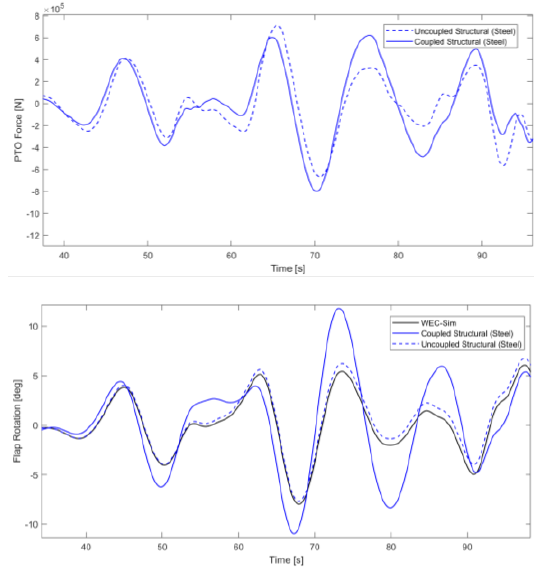
Fig. 14. Times series of flap rotation (at the centre of gravity, bottom figure), and PTO velocity (top figure) – WEC-Sim rigid-body solution (black), uncoupled analysis (blue dashed) and coupled analysis (blue) – steel material